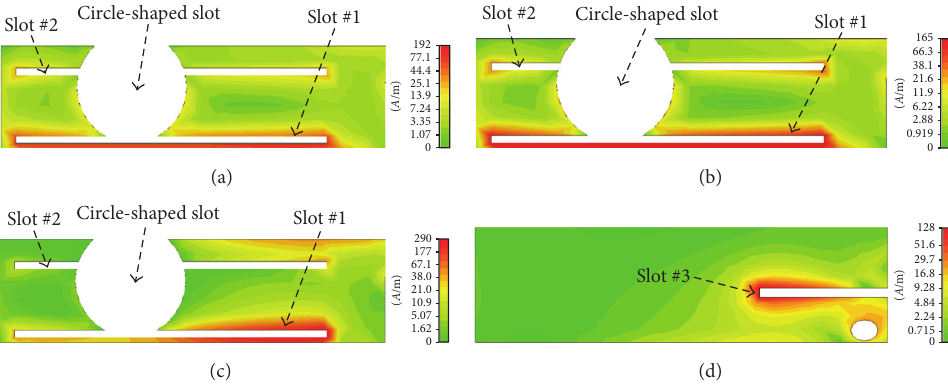
Figure 5: Surface current distribution of the proposed PIFA: (a) at 790 MHz, (b) at 1870MHz, (c) at 2550 MHz, and (d) at 3400 MHz.